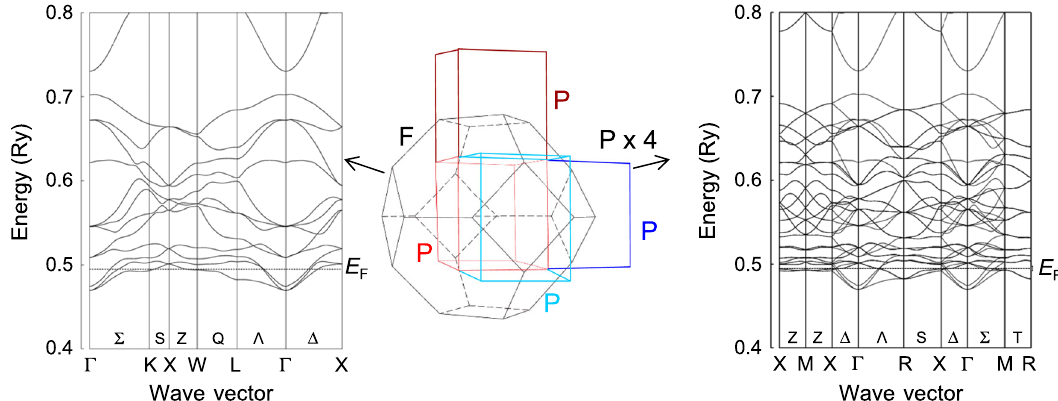
Fig. 3 First principles calculations of Phase I calculated with spin – orbit coupling. The left panel is the electronic band structure based on the Brillouin zone of the face-centered cubic lattice, which is shown by black solid lines in the center panel. In the right panel, four band structures based on four primitive cells, which are shown by red, brown, pale blue, and blue solid lines in the center panel, respectively, overlap in the